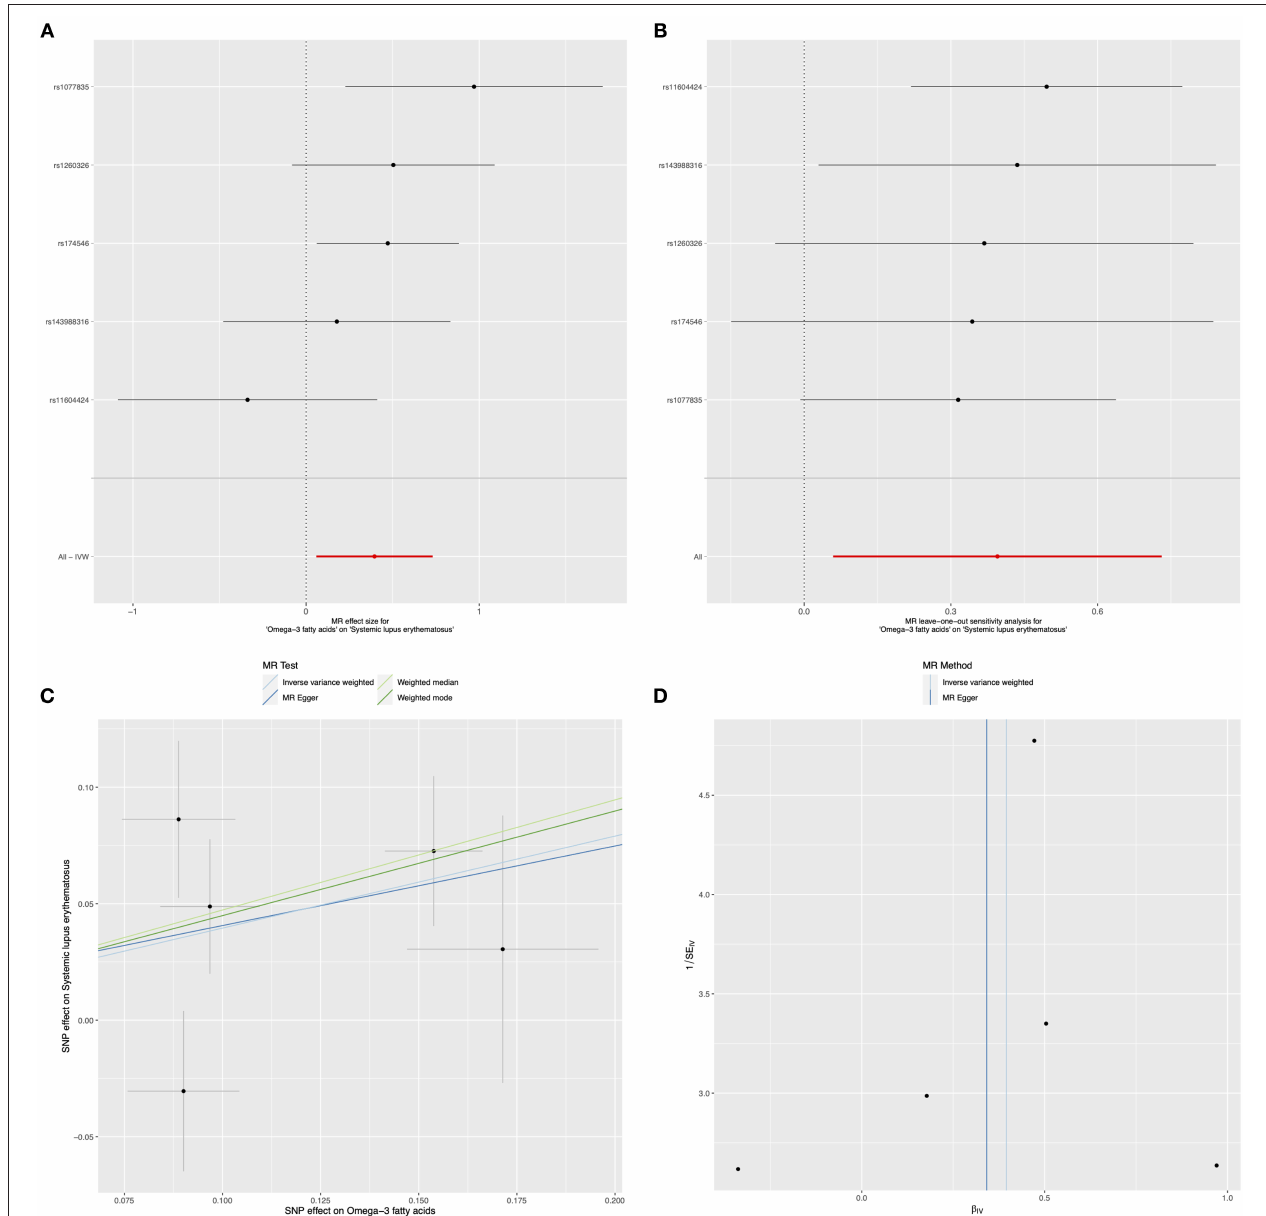
FIGURE 2 | Mendelian randomization study of the effects of omega-3 levels on systemic lupus erythematosus (SLE). Forest plot (A) , leave-one-out sensitivity analysis (B) , scatter plot (C) , and funnel plot (D) of the effect of circulating omega-3 levels on SLE.